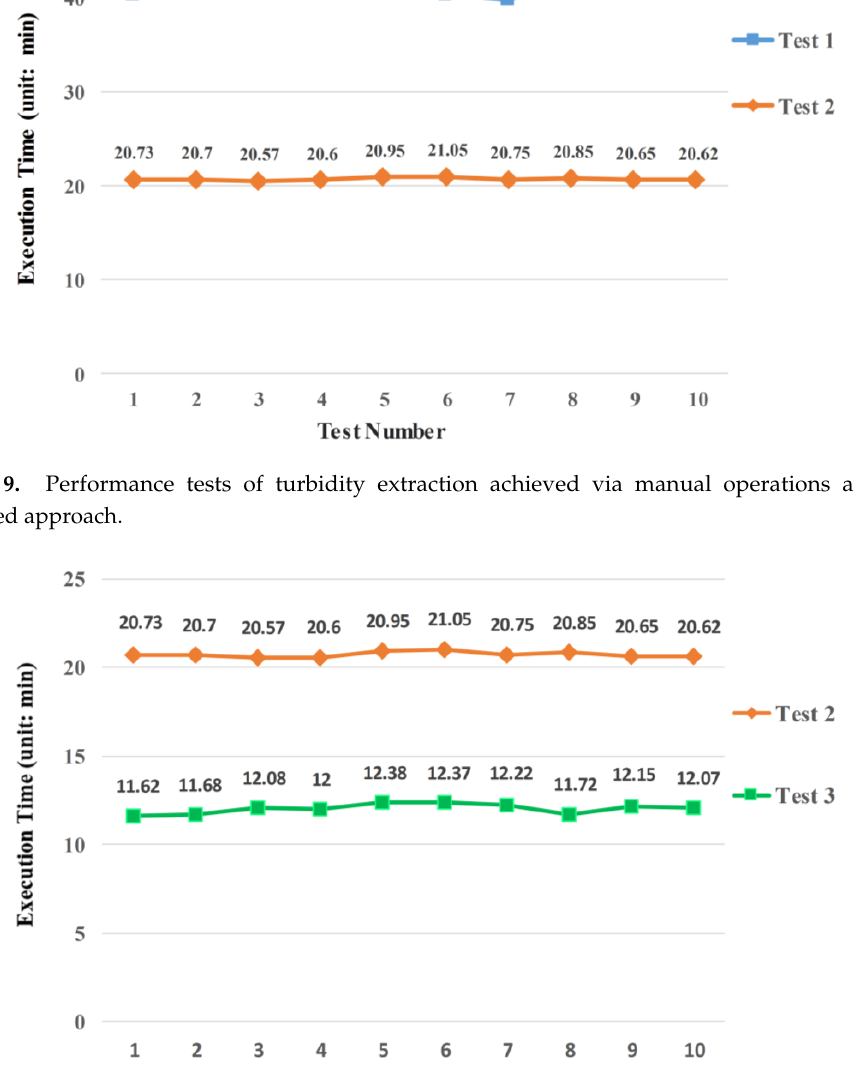
Figure 10. Performance tests of turbidity extraction on different servers.